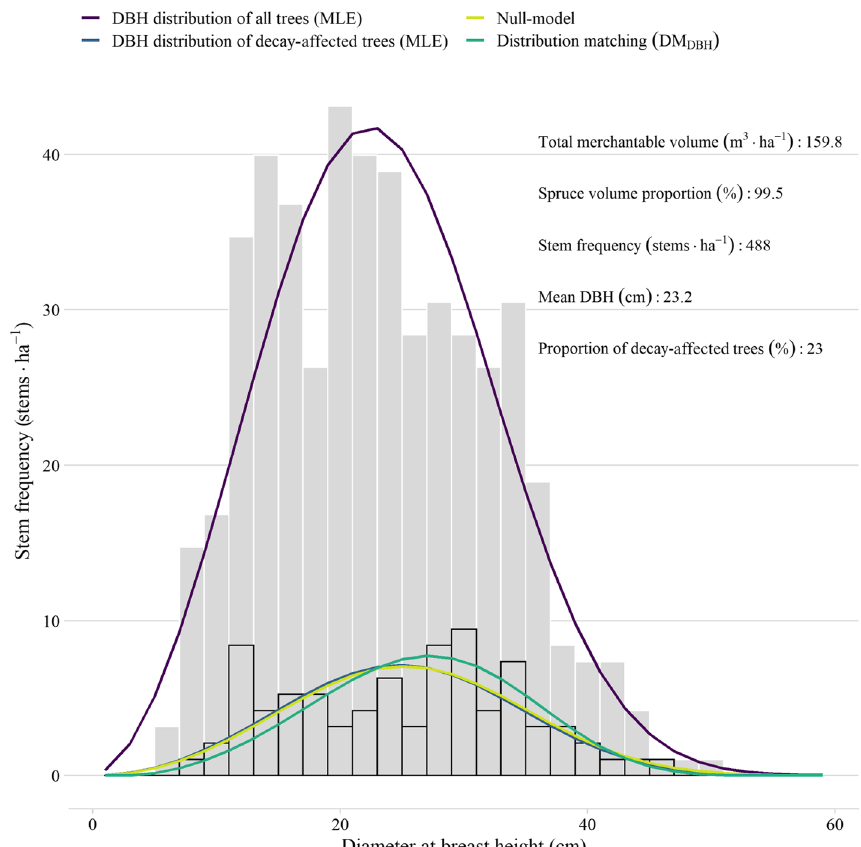
Fig. 7 Example of the harvested segment that produced an average error index ( EI of diameter at breast height (DBH) distribution of decay-affected trees. The gray bars show the DBH distribution of all trees, whereas the bars with black borders refer to the DBH distribution of decay-affected trees. Note that density distributions were scaled using observed stem frequencies. MLE, maximum likelihood